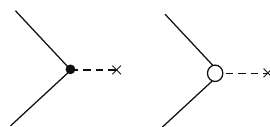
Figure 1: EM interaction vertex. The left one is the bare vertex, and the right one is the full vertex. The solid line denotes the fermion line and the dashed line denotes the photon line.